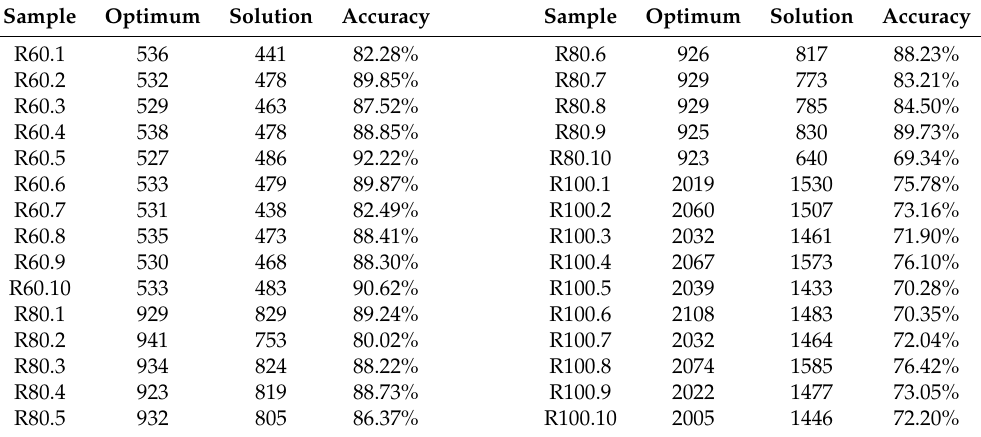
Table 5. Solution and accuracy on Biq Mac Library data set by